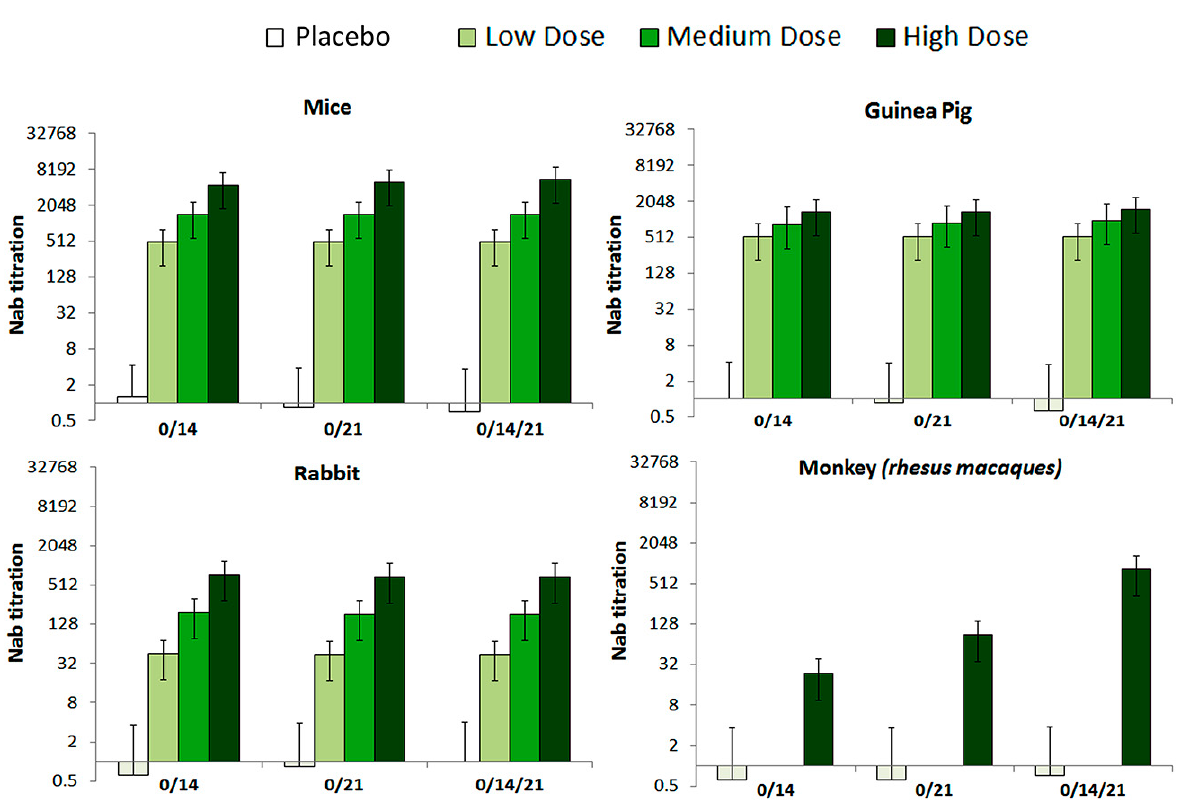
Figure 4. The NAb levels of mice, Guinea pig, Rabbit and Rhesus macaques monkey with different immunization programs. Animals were injected with High (10 μ g), Medium (5 μ g), or low (1 μ g) doses of vaccine, correspondingly via, two-dose (0/14, 0/21), and three-dose (0/14/21) immunization programs, respectively. The NAb levels measured by microtitration method, 28–42 days after the first immunization (n = 10 for all animals). The serum dilution is calculated according to Karber method in logarithmic scale (Log2(1:X)) and what is presented in graphs is the Nab titration, which is result of 1:10, 1:100 and 1:1000 dilution of active virus/sera.